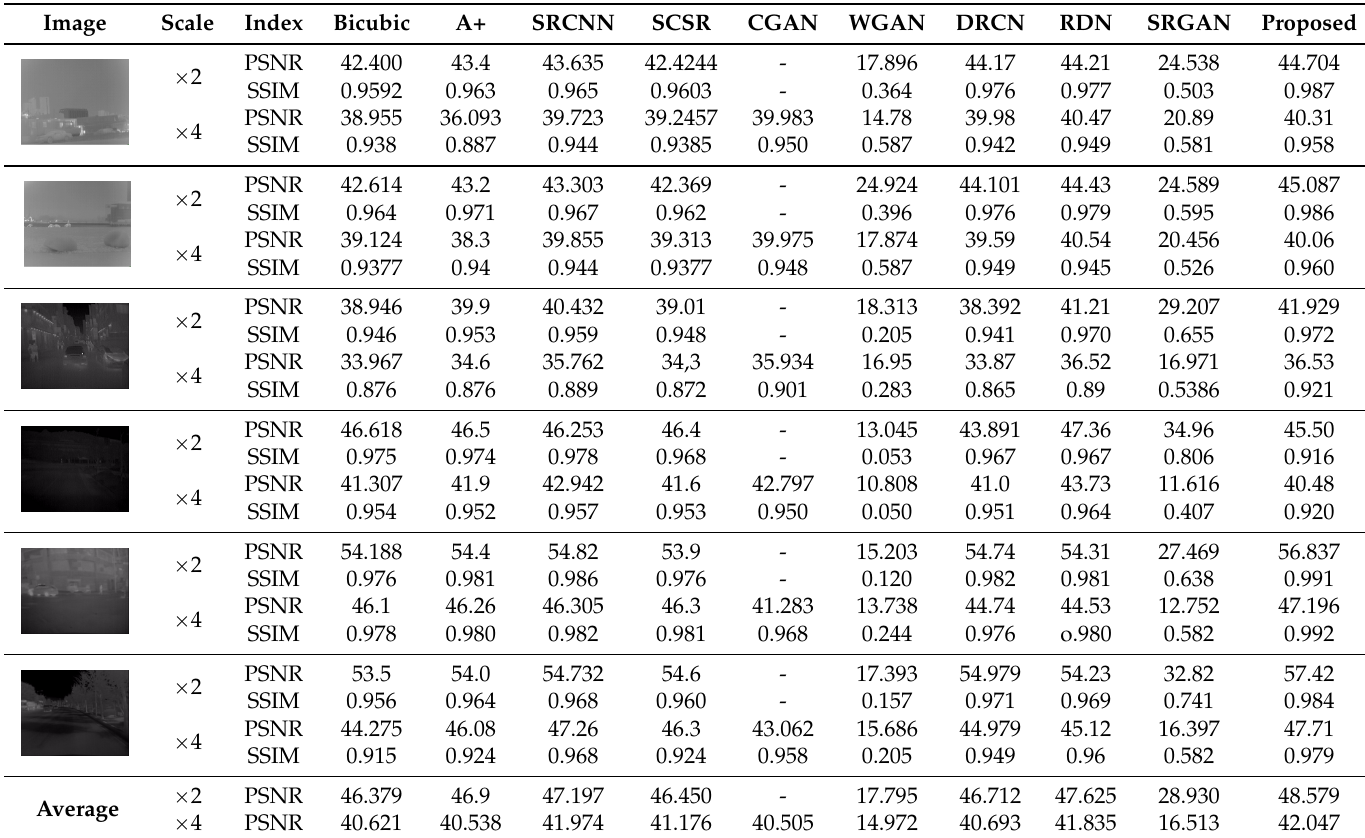
Table 4. Quantitative evaluation of a few images from KAIST and OutdoorUrban